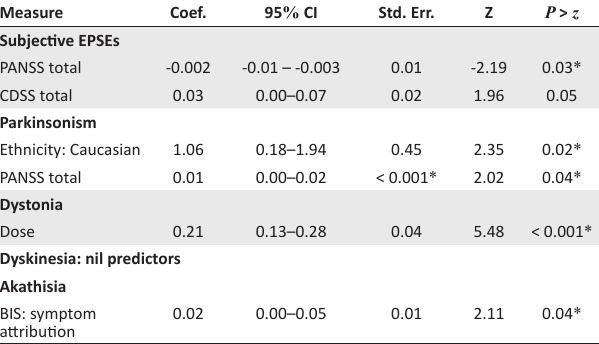
TABLE 2: Linear mixed-effect repeated measure model: Clinical and demographic predictors of extrapyramidal side effects. Measure